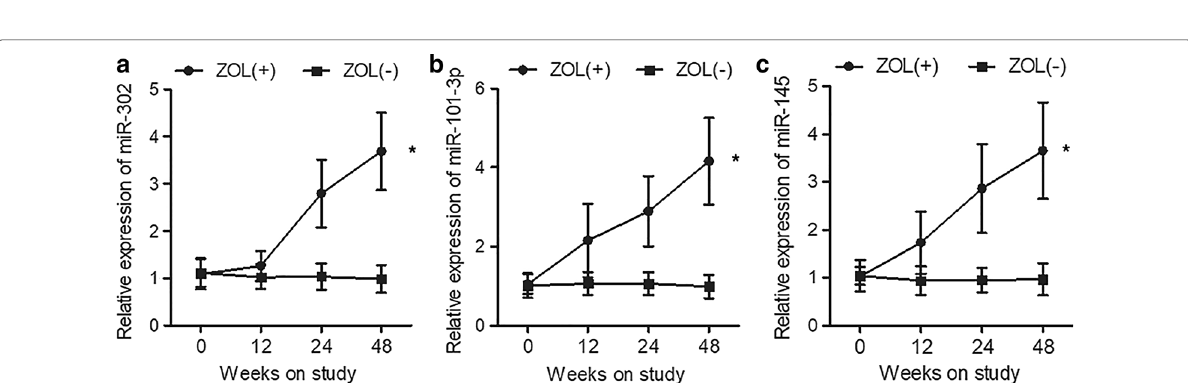
Fig. 3 The expression of miR‑302, miR‑101 and miR‑145 in the serum of HIV patients receiving tenofovir treatment was increased by ZOL treatment. a ZOL treatment enhanced the expression of miR‑302 in the serum of HIV patients receiving tenofovir treatment. b ZOL treatment enhanced the expression of miR‑101 in the serum of HIV patients receiving tenofovir treatment. c ZOL treatment enhanced the expression of miR‑145 in the serum of HIV patients receiving tenofovir